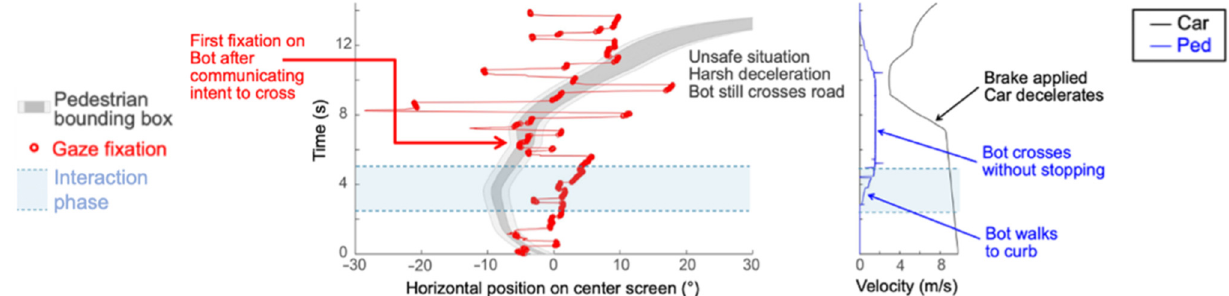
Figure A1. Data for a participant with a left HVFD for an event in which a Bot crosses from the left (blind) side of the participant in a drive when the ADAS was not engaged. Left panel shows the participant’s gaze behavior (red dots are fixations) and pedestrian position in degrees of visual angle on the center screen of the simulator (dark gray area demarks the outer limits of the bounding box surrounding the pedestrian, the light shading indicates 1° of visual angle around the bounding box). The light blue shaded area indicates the interaction phase. The right side of the plot shows the pedestrians’ velocity (blue line) and the participant’s velocity (black line) in meters per second [m/s]. The participant never looks at the Bot during the interaction phase; thus, the Bot is not seen during the interaction phase, as it is in the blind hemifield. Since there was no hazard warning, there was nothing to guide the participant to look to the left. As the Bot was already crossing the road, the participant made a late fixation on the Bot. The participant had to decelerate harshly since the Bot did not stop. The situation was categorized as unsafe.